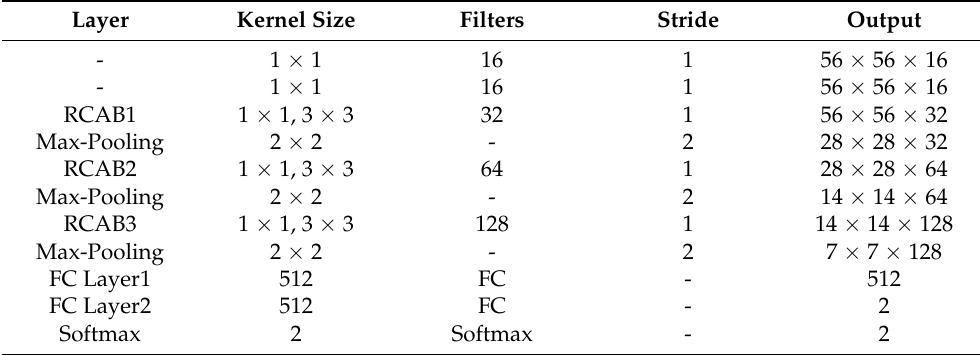
Table 1. The structure of the